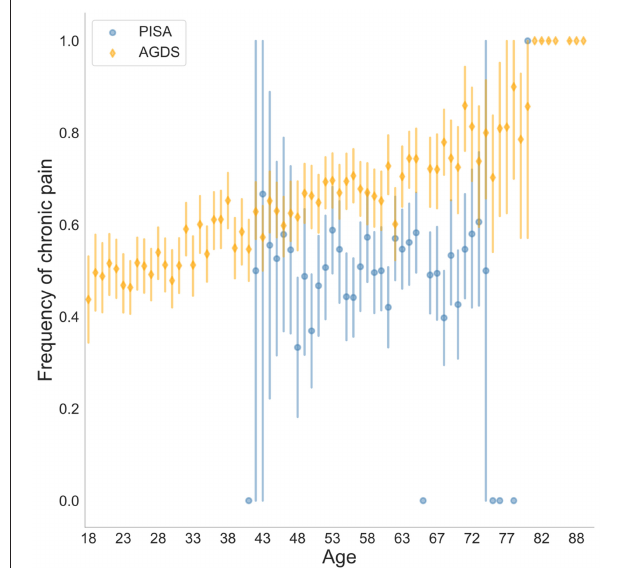
FIGURE 1 | Prevalence of chronic pain stratified by age and cohort (AGDS vs. PISA). Self-reported chronic pain was significantly higher in the AGDS cohort ( N = 6,895/11,370) compared with the PISA cohort ( N = 1,248/2,469)—OR = 1.31 (0.96–1.77); p = 0.086. For other statistical significance results see Supplementary Table 1 . Both cohorts are population-based samples with AGDS being enriched for